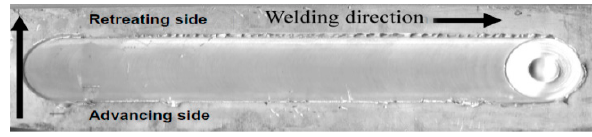
Figure 2. Welded plates after FSW process.